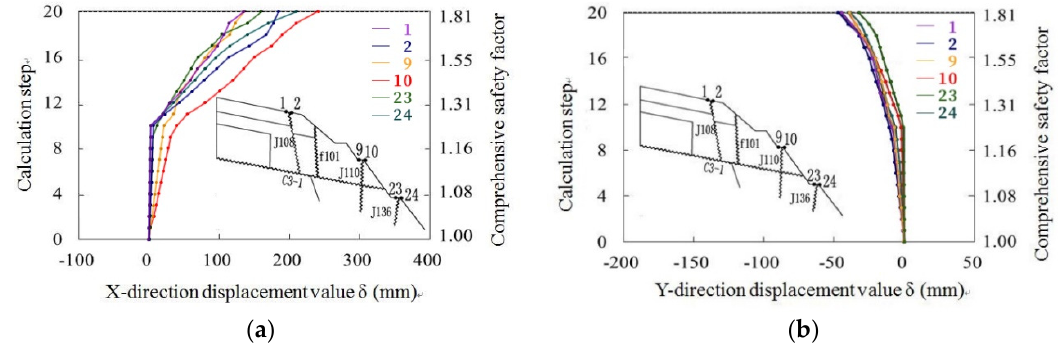
Figure 16. Typical curve of slope surface displacement. ( a ) Horizontal displacement; ( b ) vertical displacement.